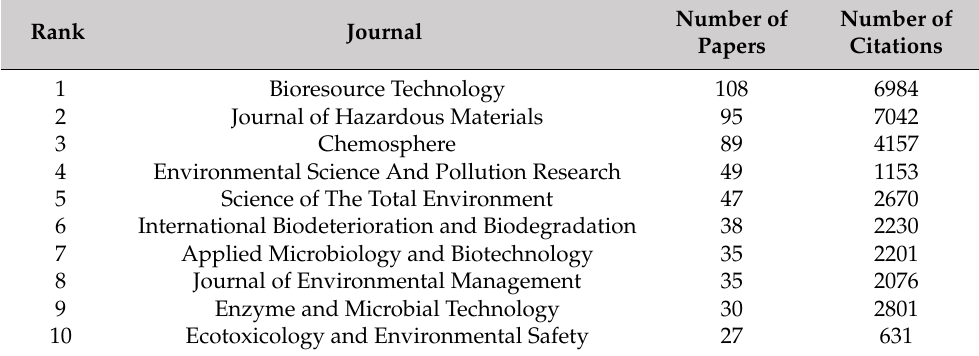
Table 2. Top 10 journals publishing articles related to laccase-assisted wastewater treatment.